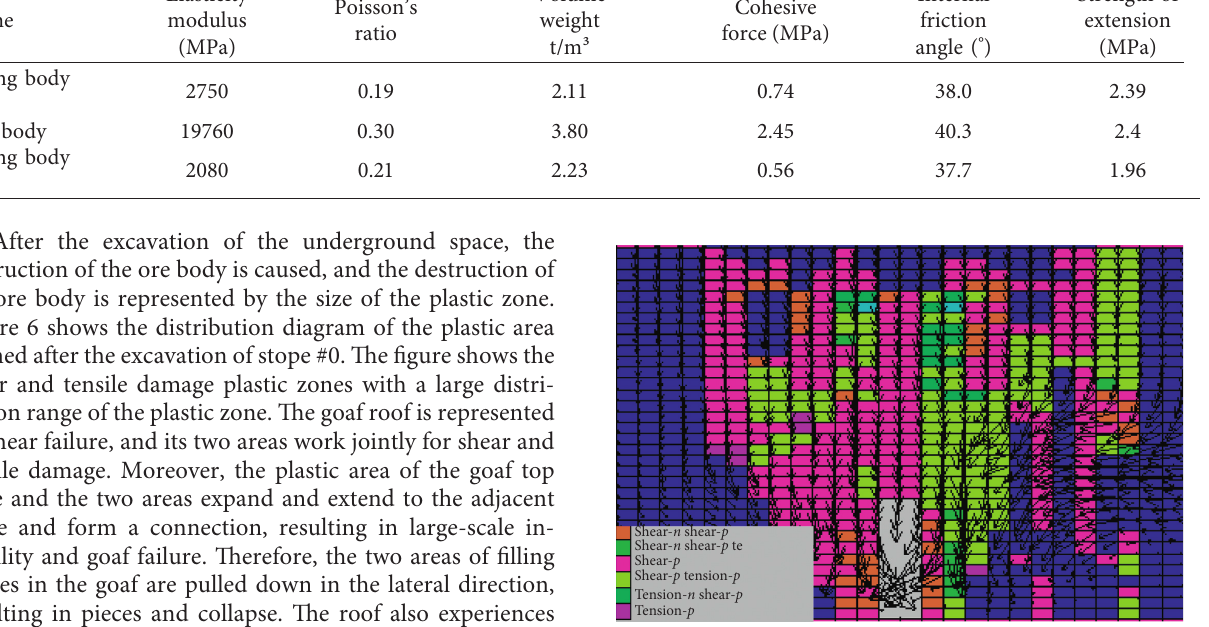
Figure 6: Plastic zone of the instability mining collapse area.